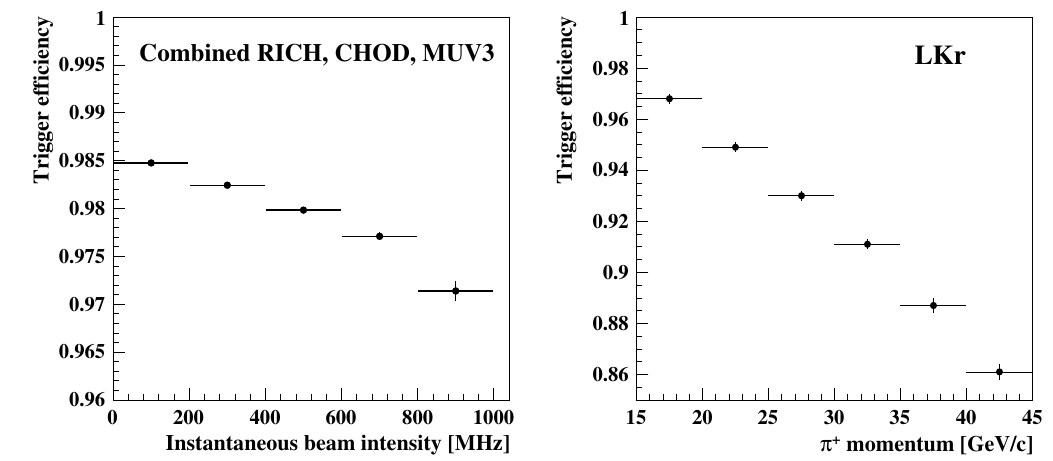
Figure 4. Efficiency of the combined RICH, CHOD, and MUV3 conditions of the PNN trigger line evaluated using K + → π + π 0 events as a function of instantaneous beam intensity (left), and efficiency of the LKr condition of the PNN trigger line evaluated using K + → π + π 0 events as a function of the π + momentum